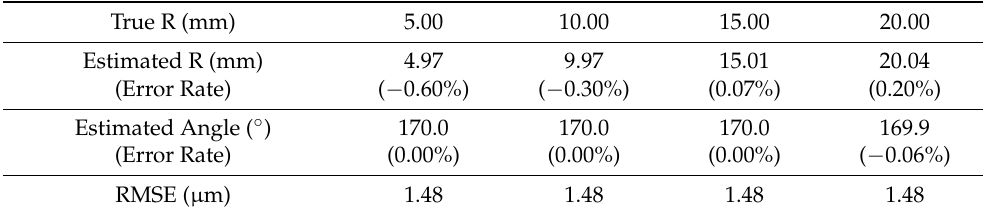
Table 2. Estimated arc radii and angles for different radii with an angle of 170 ◦ .